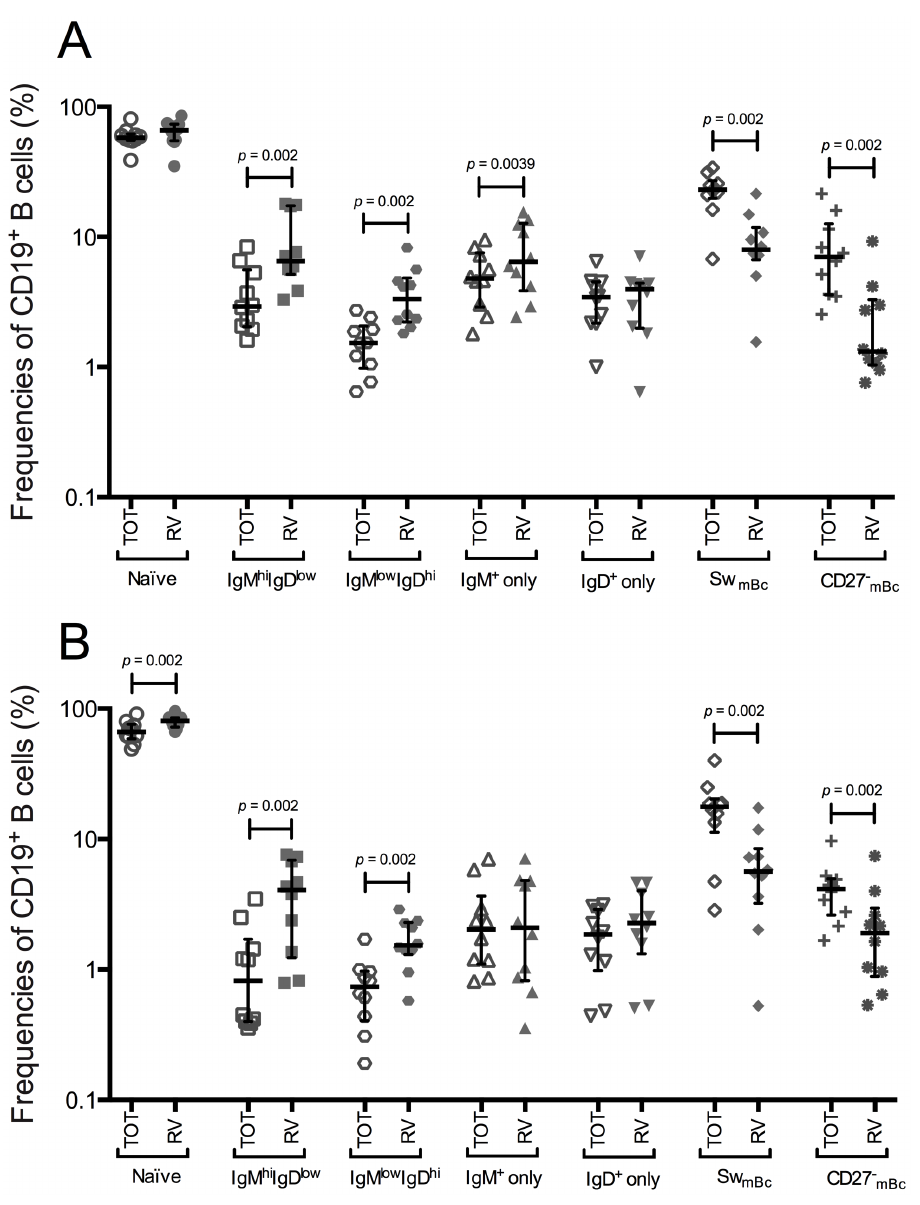
Figure 1. RV-mBc are enriched in the IgM hi IgD low , IgM low IgD hi , and IgM + only mBc subsets. Summary of the frequencies of seven subsets of total and RV-mBc assessed by multiparametric flow cytometry. All p values reported are 2-tailed ( p , 0.05, Wilcoxon test). Lines and error bars denote the median and interquartile range, respectively. A . Healthy volunteers (n=10). B . Patients (n=10) with autoimmune diseases before RTX